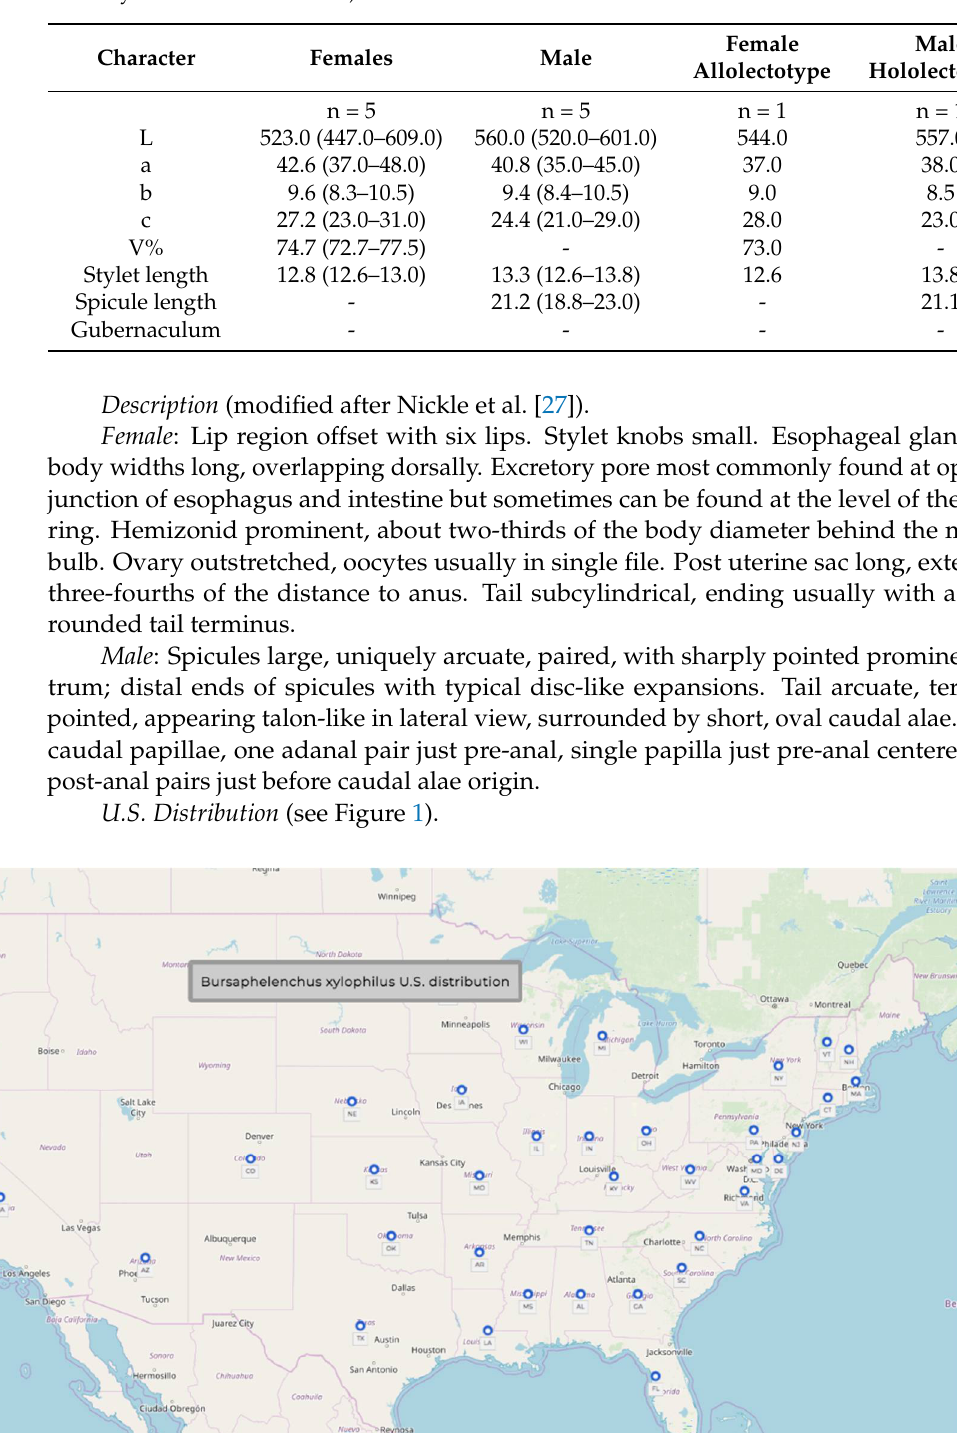
Table 1. Bursaphelenchus xylophilus morphometrics of females and males (after Nickle et al. [27]